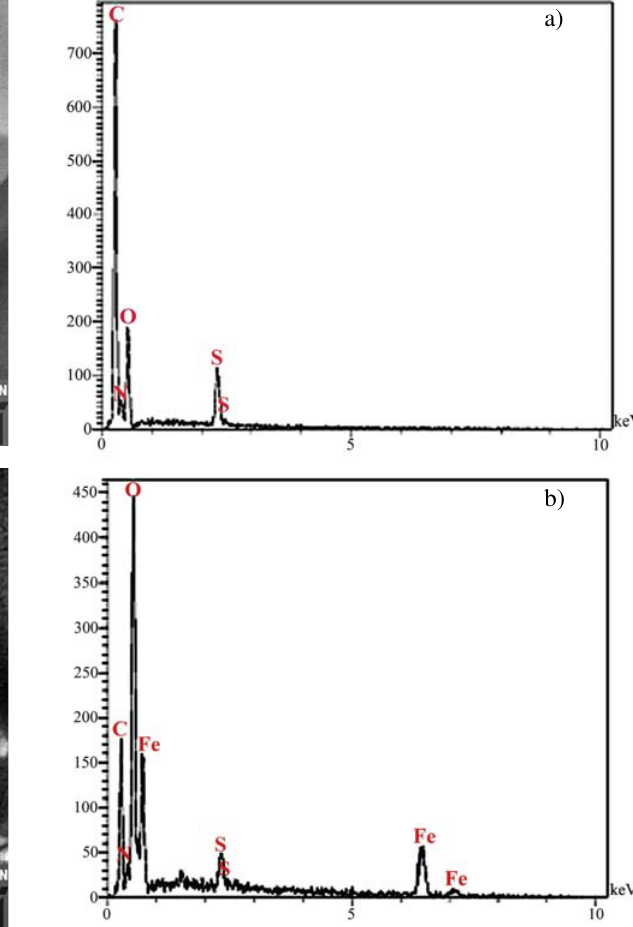
Figure 4. EDS spectra of poly(AMPS- co -AA) (a) and poly(AMPS - co -AA) @ Fe